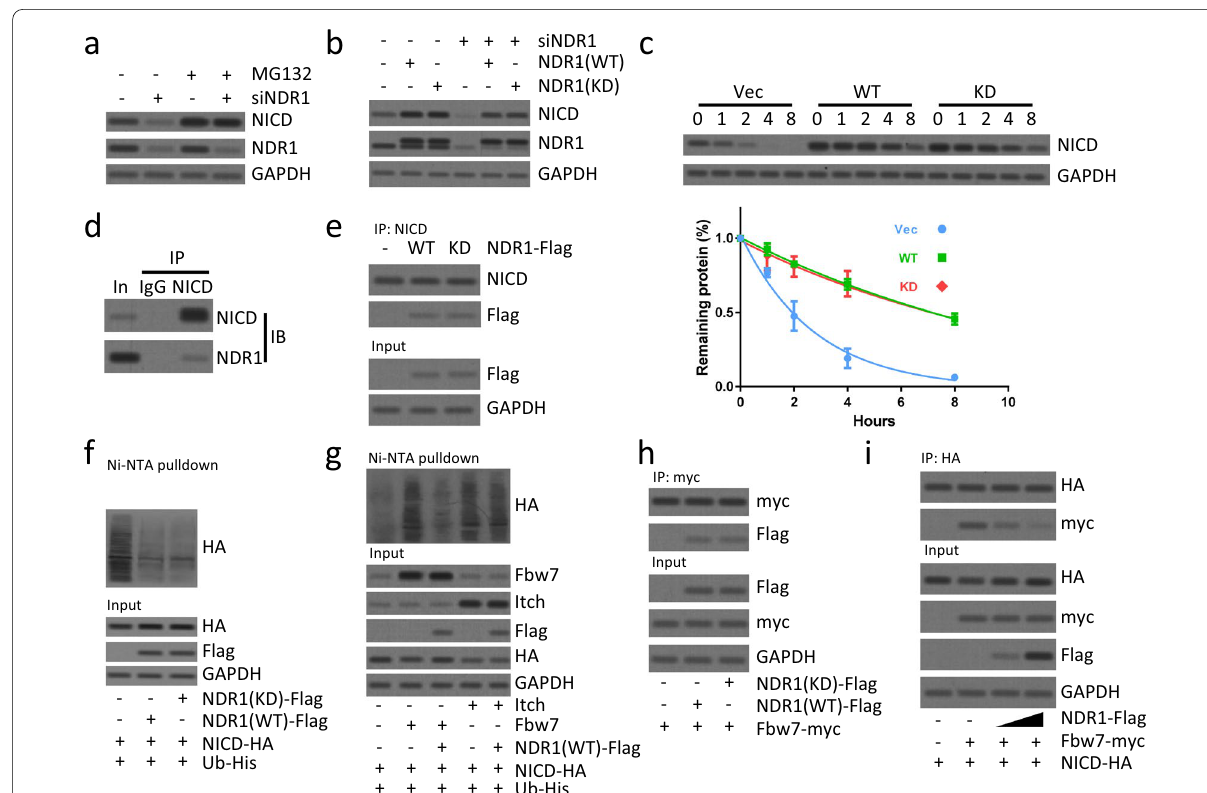
Fig. 5 NDR1 suppresses FBW7 mediated degradation of NICD in breast cancer cells. a NDR1 siRNA or control siRNA were transfected in SUM149 cells for 48 h. Then, cells were treated with MG132 (10 μM) for 2 h. Cells were harvested and subjected to western blot analysis. b NDR1 siRNA or control siRNA were transfected in SUM149 cells for 48 h. Then, wild type or kinase‑dead (K118A) NDR1 was overexpressed for 24 h. Cells were harvested and subjected to western blot analysis. c Wild type, kinase‑dead NDR1 or control vector was overexpressed in SUM149 cells for 24 h. Cells were treated with CHX (50 µg/ml) for the indicated time. Cells were harvested and subjected to western blot analysis. The densitometric quantification of NICD normalized to GAPDH was plotted against various time points to determine the half‑life of NICD. d The total protein of SUM149 cells was subjected to immunoprecipitation and western blot analysis using antibodies as indicated. e Wild type, kinase‑dead NDR1 or control vector was overexpressed in SUM149 cells for 24 h. The total protein of SUM149 cells was subjected to immunoprecipitation and western blot analysis using antibodies as indicated. f , g SUM149 cells were transfected with indicated vectors for 24 h. Cells were subsequently treated with MG132 (10 μM) for 2 h prior to ubiquitination proteins were pulldown with Ni–NTA beads and followed by western blot analysis for indicated proteins. h , i SUM149 cells were transfected with indicated vectors for 24 h. The total protein of SUM149 cells was subjected to immunoprecipitation and western blot analysis using antibodies as